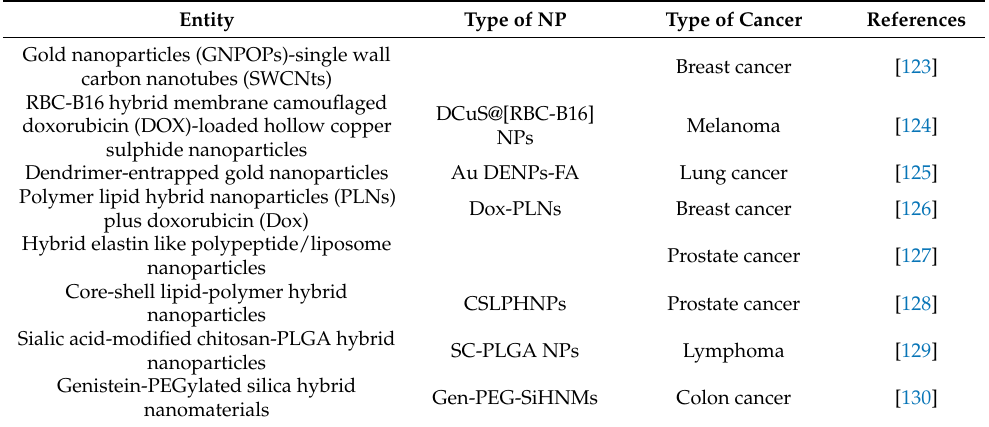
Table 7. Types of hybrid nanoparticles and their applications in cancer